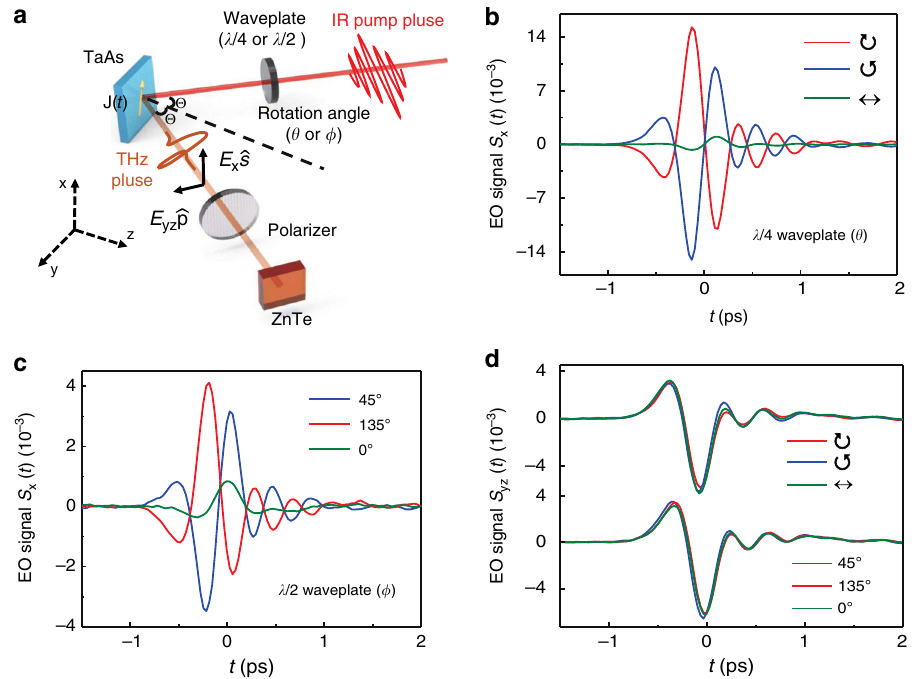
Fig. 1 THz emission from the Weyl semimetal TaAs. a Schematic of the THz emission spectroscopy. Excitation of a fs laser pulse with an incident angle Θ onto a TaAs single crystal initiates a photocurrent burst and, consequently, emission of a THz pulse E ( t )[ ¼ E components E x ( t ) and E yz ( t ) by the THz EO sampling provides access to the sheet current density J ( t ) fl owing inside the sample. b – d Typical THz EO signal components S x ( t ) and S yz ( t ) along the ^ s and ^ p directions were measured at various settings for pump polarization via rotating the λ ∕ 4 or λ ∕ 2 waveplate, characterized by the angle θ or ϕ , respectively. Here, ↔ ( θ = 0 ∘ ), ↻ ( θ = 45 ∘ ), and ↺ ( θ = 135 ∘ ) represent the p , right-handed, and left-handed circularly polarized light, respectively. The angle ϕ stands for the linear polarization state with respect to the p -polarized light ( ϕ = 0 ∘ ).